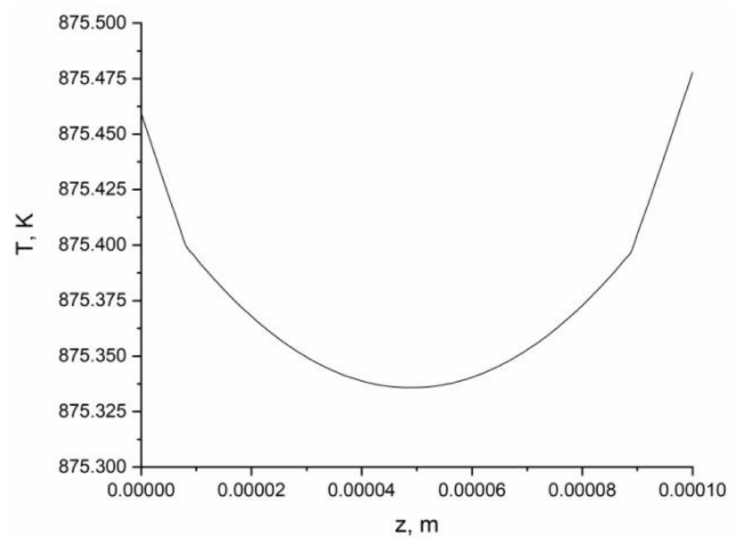
Figure 5. Distribution of temperature over the thickness of a birch leaf under the influence of a low-intensity surface forest fire at time t = 5 s (summer, July, +20 ◦ C, ϕ 30 = 0.4).